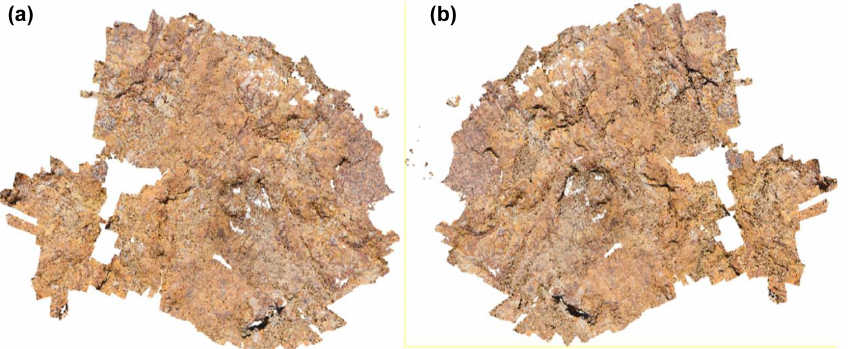
Figure 6. Front and back view of Cristo Rey 3-D PDF image from grid sections (3, 4) to (3, 5) and (4, 4) to (4, 6). Each image occupies an area of approximately 2m by 2m. Panel (a) shows what a field observer would see in the fossil locality, and panel (b) shows the same image as panel (a) but reversed to show the back side of the fossil image which a field observer would not see.